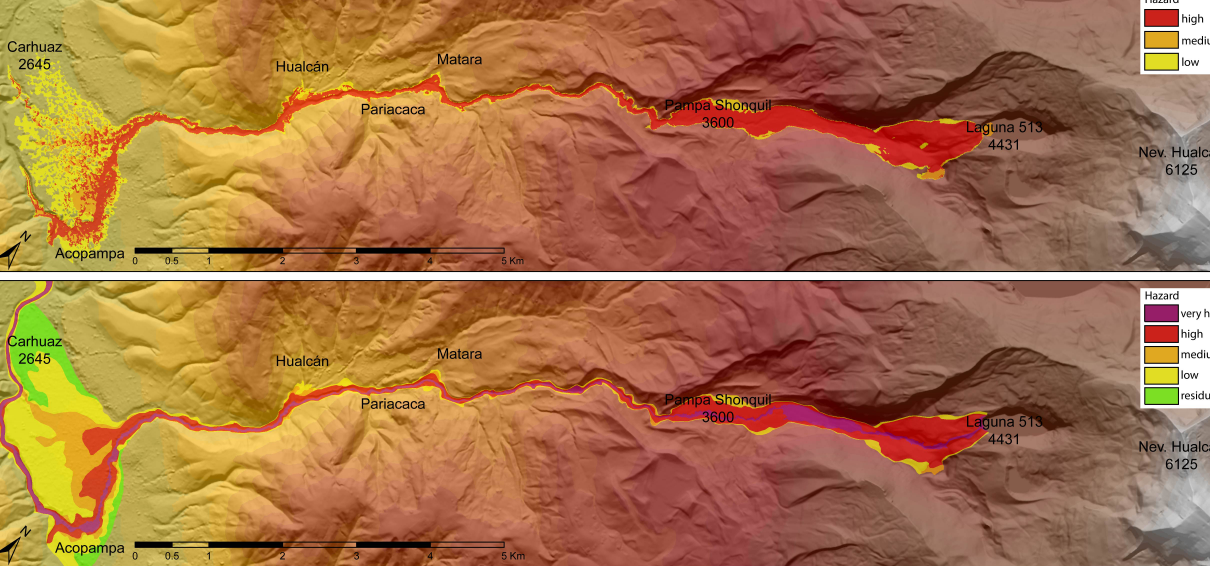
Fig. 7. Upper panel: raw form of hazard map derived from modeling results with RAMMS. In this map all three scenarios are included (for each cell, the highest hazard category according to the scheme in Fig. 6 is relevant). Lower panel: final hazard map representing a combined and generalized product of the raw product and field work. Background: color-shaded relief of the 8m-WorldView-DEM used for the numerical